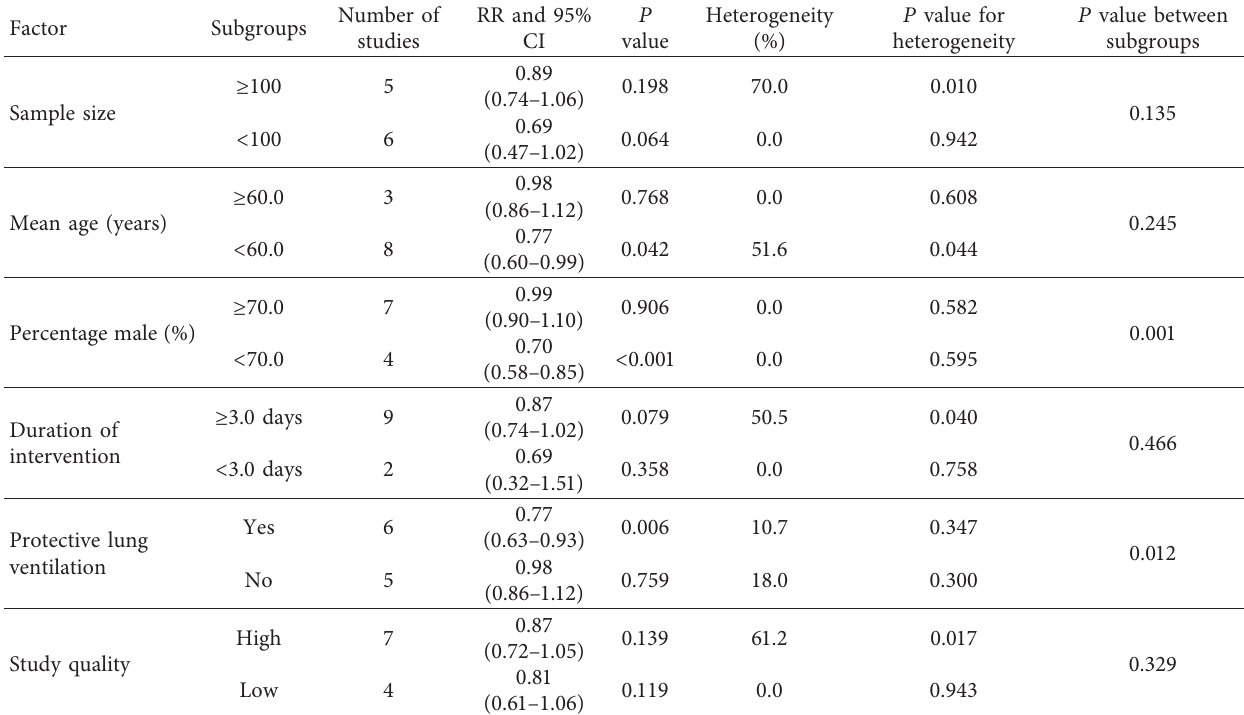
Table 3: Subgroup analysis for mortality.